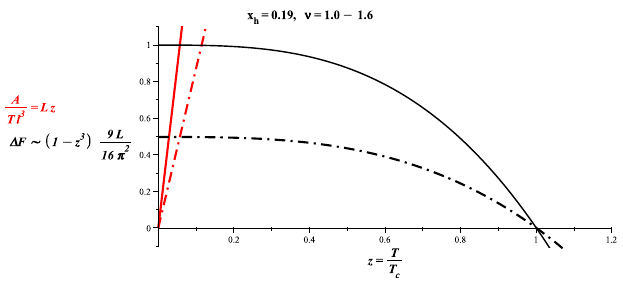
j x (cid:25) 0 : 11. L h =0 : 19 ;(cid:23) =1 : 6